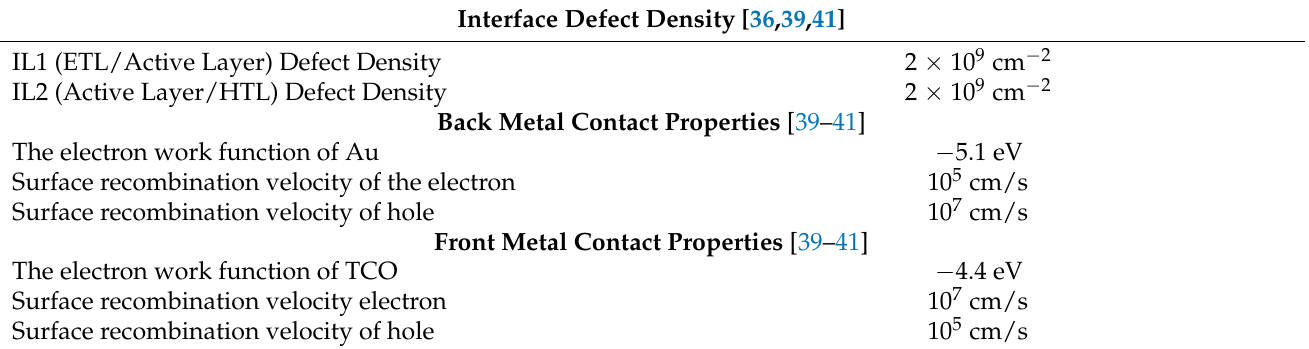
Table 2. Device parameters set in the